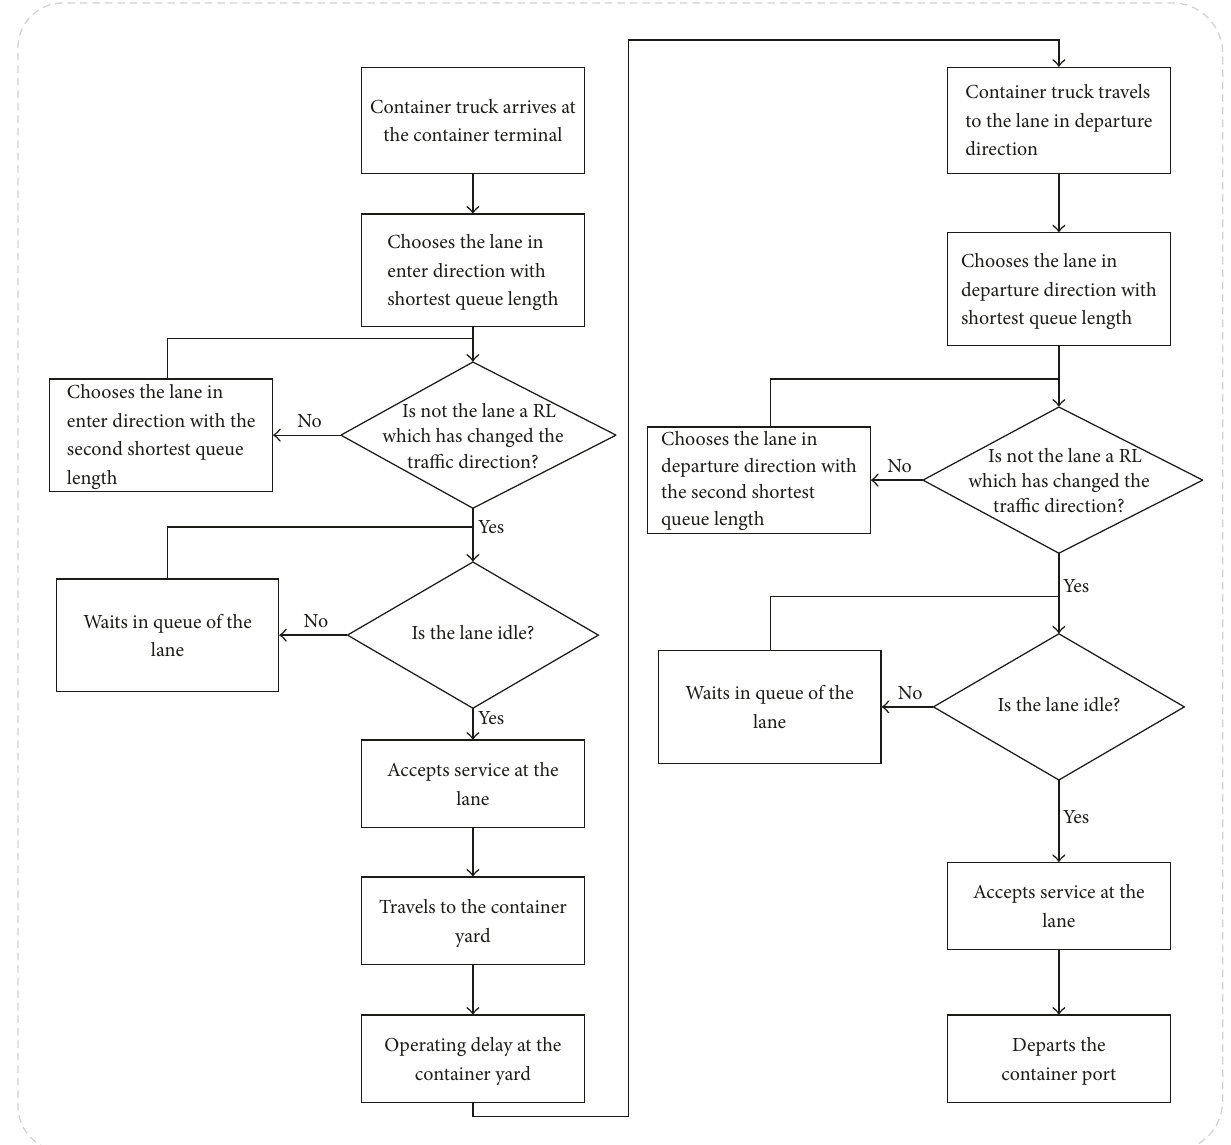
Figure 3: Logic model of the container terminal gate system with